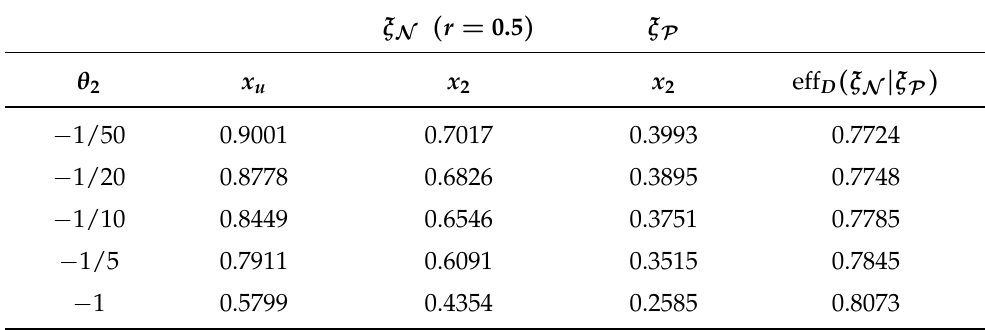
Table 3. Locally D-optimal designs { x 1 = 0, x 2 , x 3 = x u } equally weighted obtained for the linear quadratic model when the probability distribution of the response is heteroscedastic normal or Poisson. The nominal values are θ ( 0 ) = ( 0.95, − 1, θ 2 ) and the minimal survival fraction is c = 0.4. The last column shows the efficiency when comparing the design for the heteroscedastic normal distribution with r = 0.5 to the Poisson